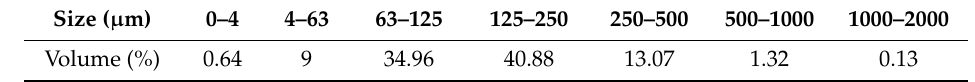
Figure 7. Particle size analysis of the synthesized UFMCs. Table 1. Particle size distribution.